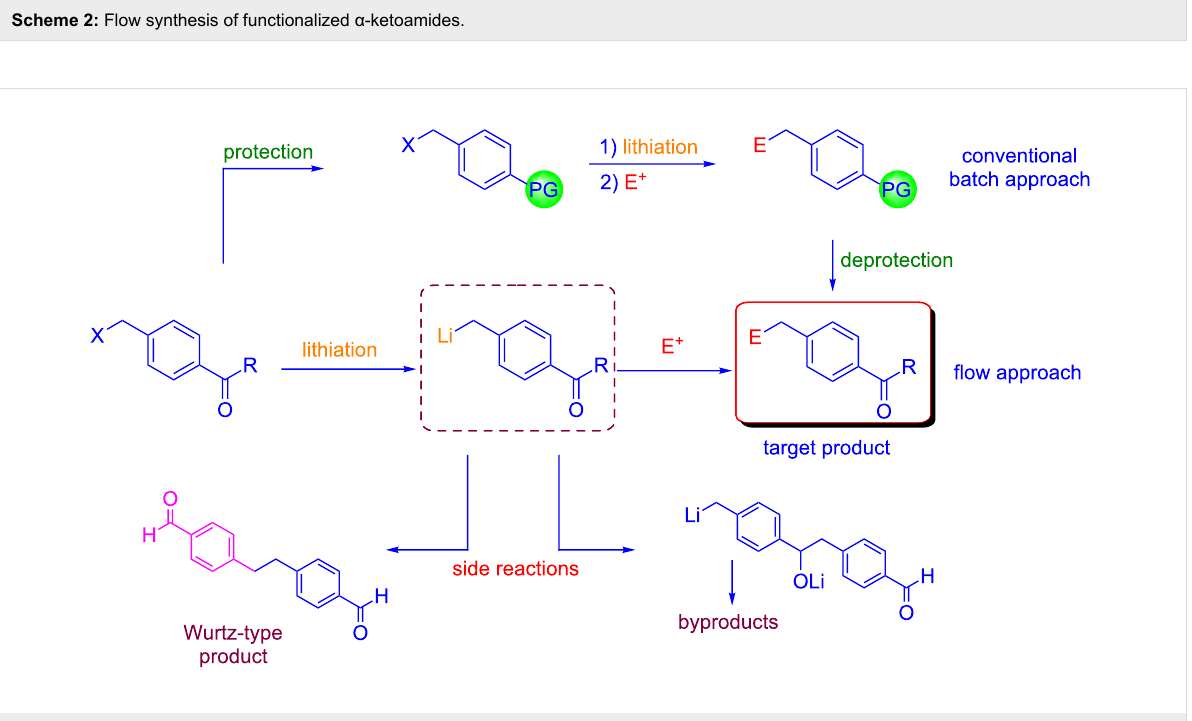
Scheme 3: Reactions of